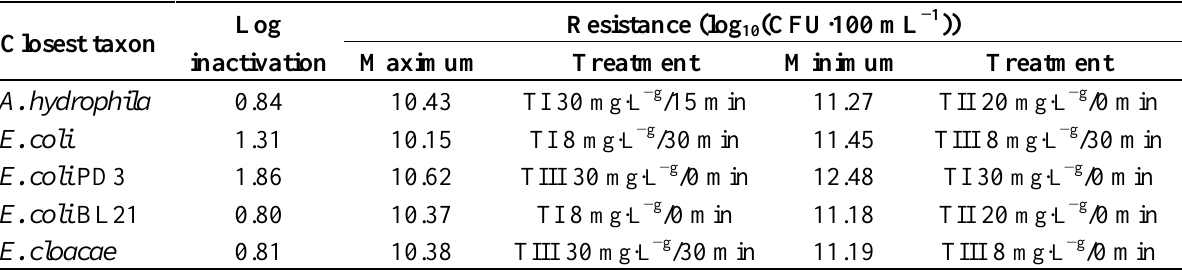
Table 2. Resistance of the bacterial strains to disinfectant